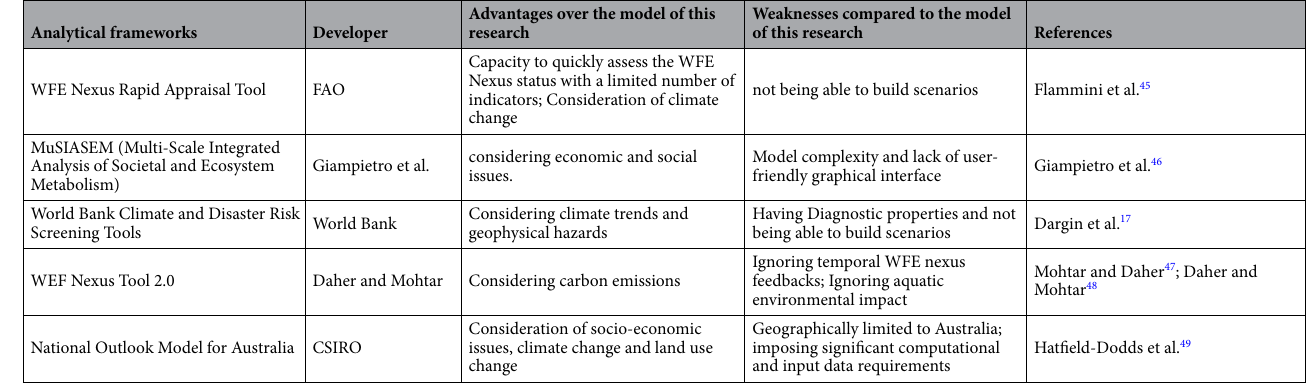
Table 1. Review of some of the key national-level WFE Nexus conceptual